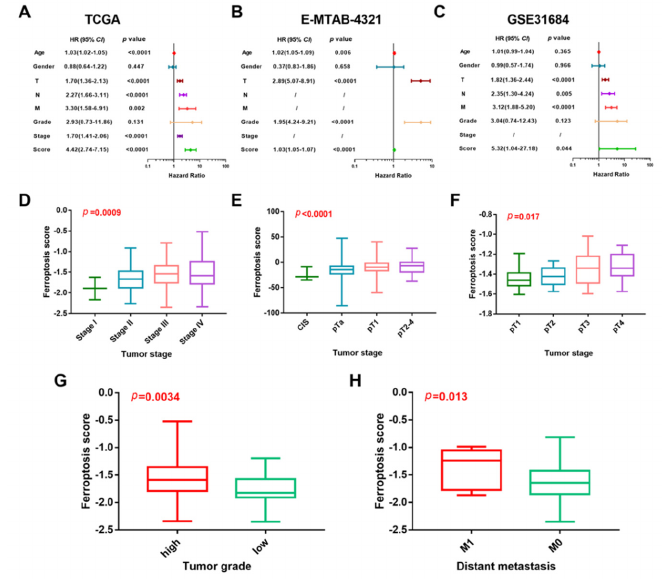
Figure 2. Evaluation of the ferroptosis-related prognosis model. ( A – C ) Univariate cox regression analyses of ferroptosis score and clinicopathologic factors in the TCGA cohort, the validation MTAB-4321 cohort, and GSE31684 cohort, respectively. ( D – F ) The different distributions of ferroptosis scores among different stages and lymph node metastasis status in the TCGA cohort, the validation MTAB-4321 cohort, and GSE31684 cohort, respectively. ( G , H ) The different distributions of ferroptosis scores between different tumor grades and distant metastasis status in the TCGA cohort. TCGA, The Cancer Genome Atlas.